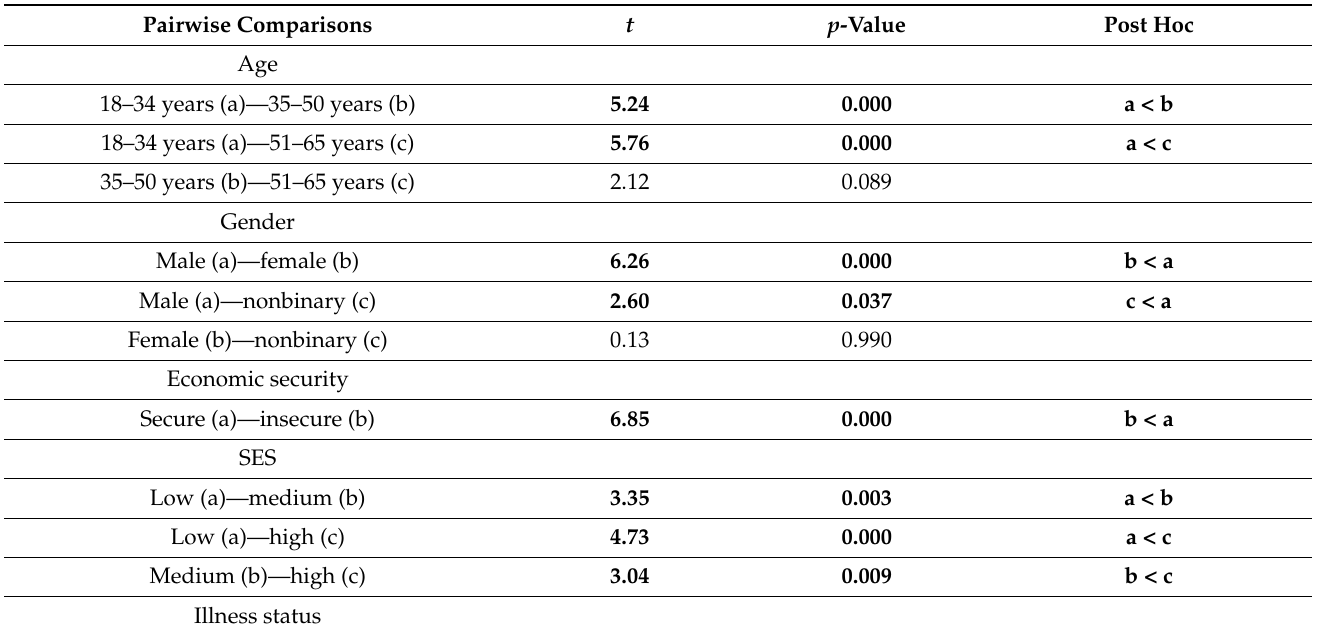
Table 3. Group differences in predictors of resilience ( N =